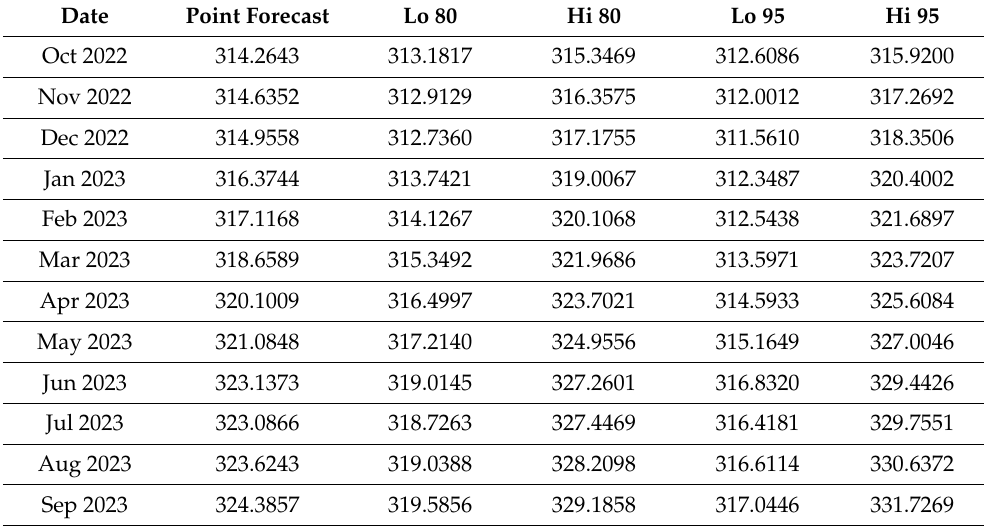
Table A2. Predicted CPI trend in New York. Own